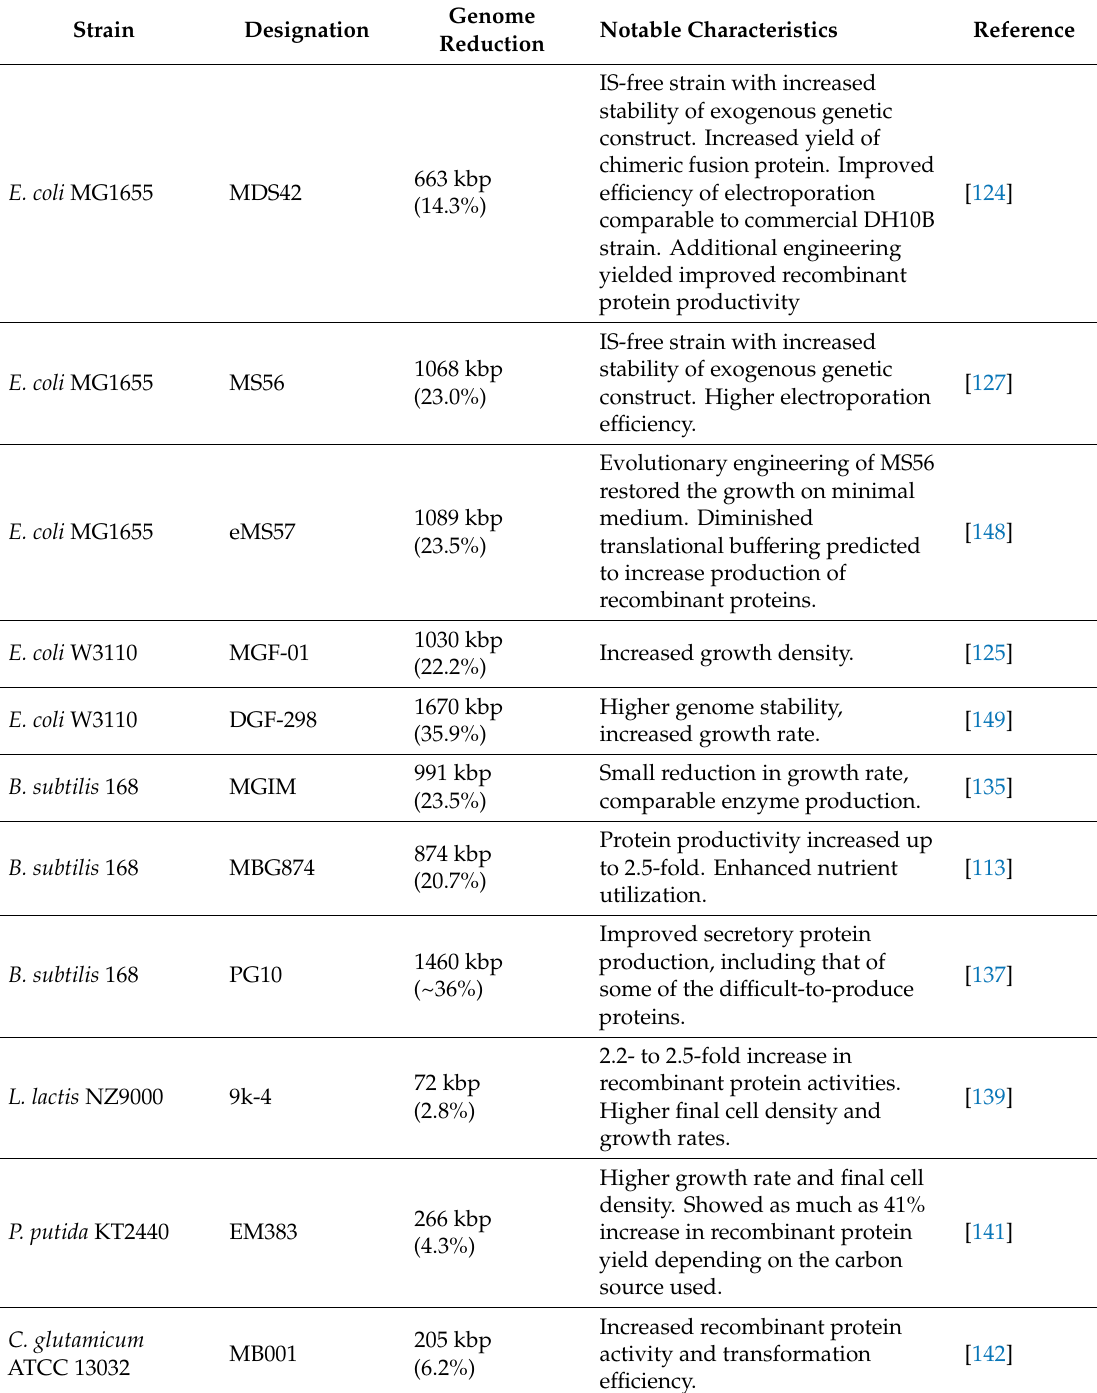
Table 2. Examples of synthetic genome-reduced strains with defining characteristics beneficial for heterologous protein